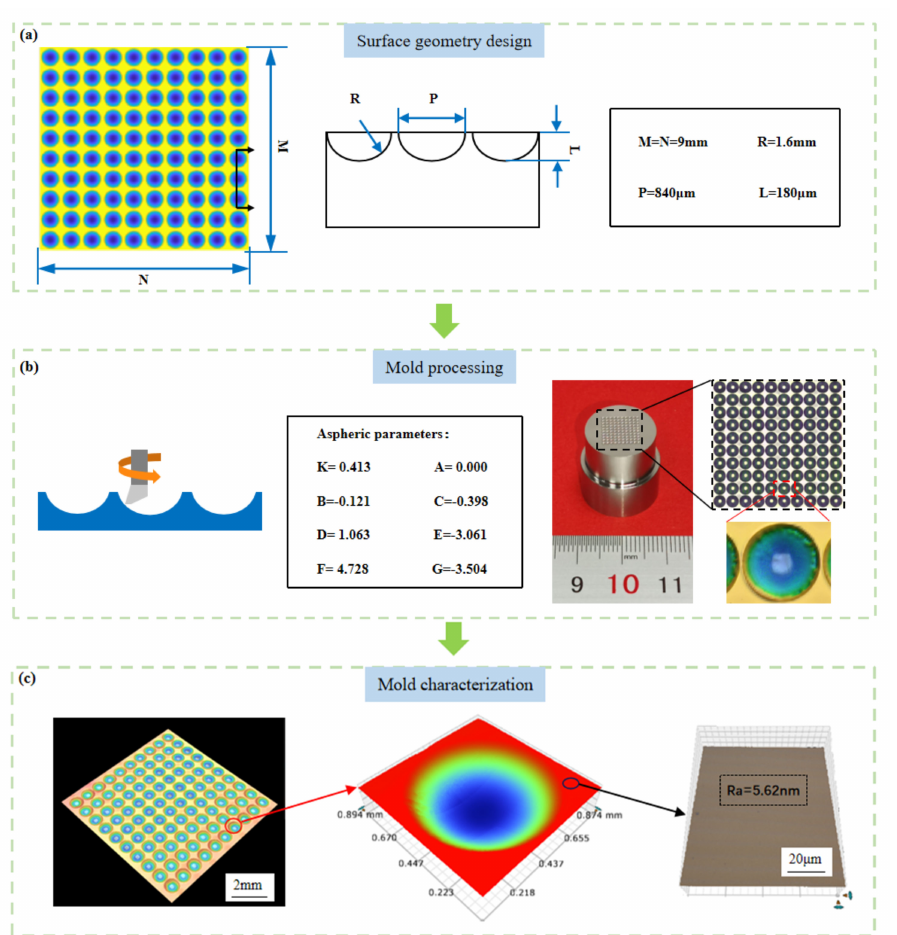
Figure 1. Aspheric microlens array mold design and processing. ( a ) Design of aspheric microlens array with basic geometric parameters, ( b ) mold processing, and ( c ) characterization of microlens array